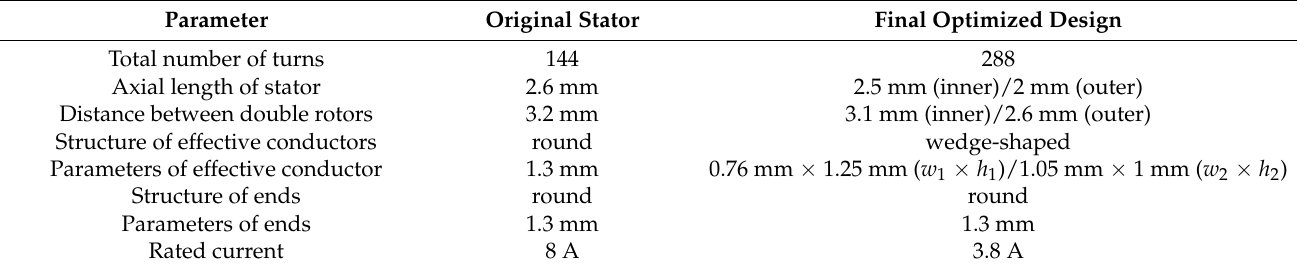
Table 3. Original and optimized parameters of the coreless stator.